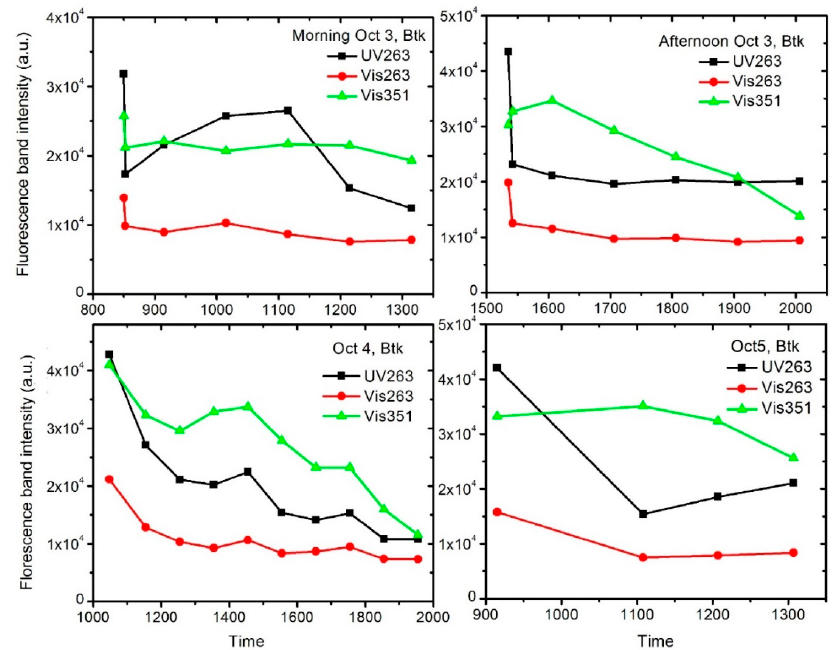
Figure 4. Changes in integrated fluorescence band intensities with time for Btk aerosol particles on 3 October (morning, top left ; afternoon, top right ), 4 October 2012 ( bottom left ), and 5 October 2012 ( bottom right ).